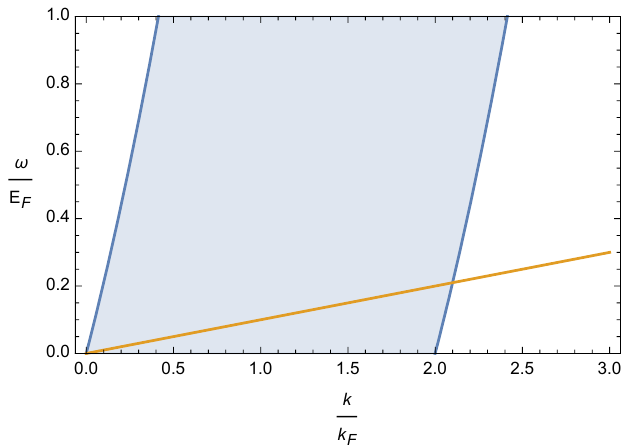
Figure 2: The shaded blue region is the phase space of Lindhard particle-hole pairs. The orange line is the dispersion of an acoustic phonon with v (18) is obeyed where the phonon is inside the particle-hole